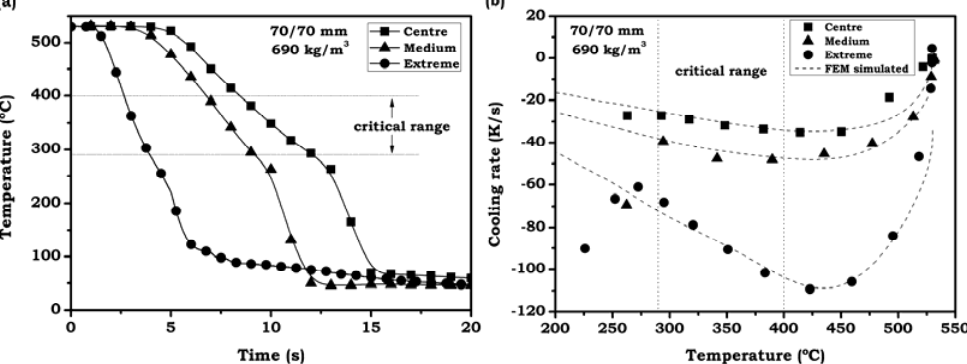
Figure 11. ( a ) Experimental cooling profiles at three different points inside the 70/70 mm foam. ( b ) Experimental data (points) and simulated cooling curves (dash lines) versus temperature.